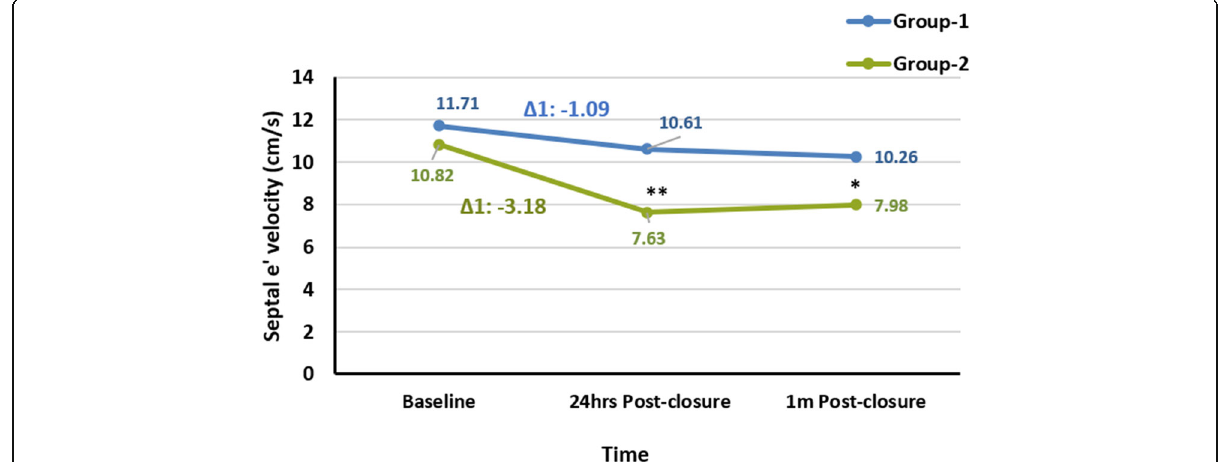
Fig. 3 Comparison of the changes in left ventricular diastolic function (septal e ′ velocity) after ASD device closure between the 2 age groups and along the time course before and after closure. A linear chart of septal e ′ velocity changes from baseline towards 24 h and 1 month post-closure in children and adolescent group-1 and marked reduction with abnormal values (7.63, 7.98 cm/s) in adult group-2 (G1- Δ 1 − 1.09 cm/s versus G2- Δ 1 − 3.18 cm/s, P = 0.019). Δ 1 = difference between 24 h post-ASD device closure and baseline values. **A highly significant difference between the 1st and 2nd groups after 24 h of ASD device closure in septal e ′ velocity ( P < 0.001). *A significant difference between the 2 groups after 1 month of ASD device closure ( P = 0.001). Group-1: children and adolescent with ASD who underwent closure at age ≤ 19 years old; group-2: adult with ASD who underwent closure at age > 19 years old. ASD, atrial septal defect; septal e ′ , early diastolic velocity of septal mitral annulus